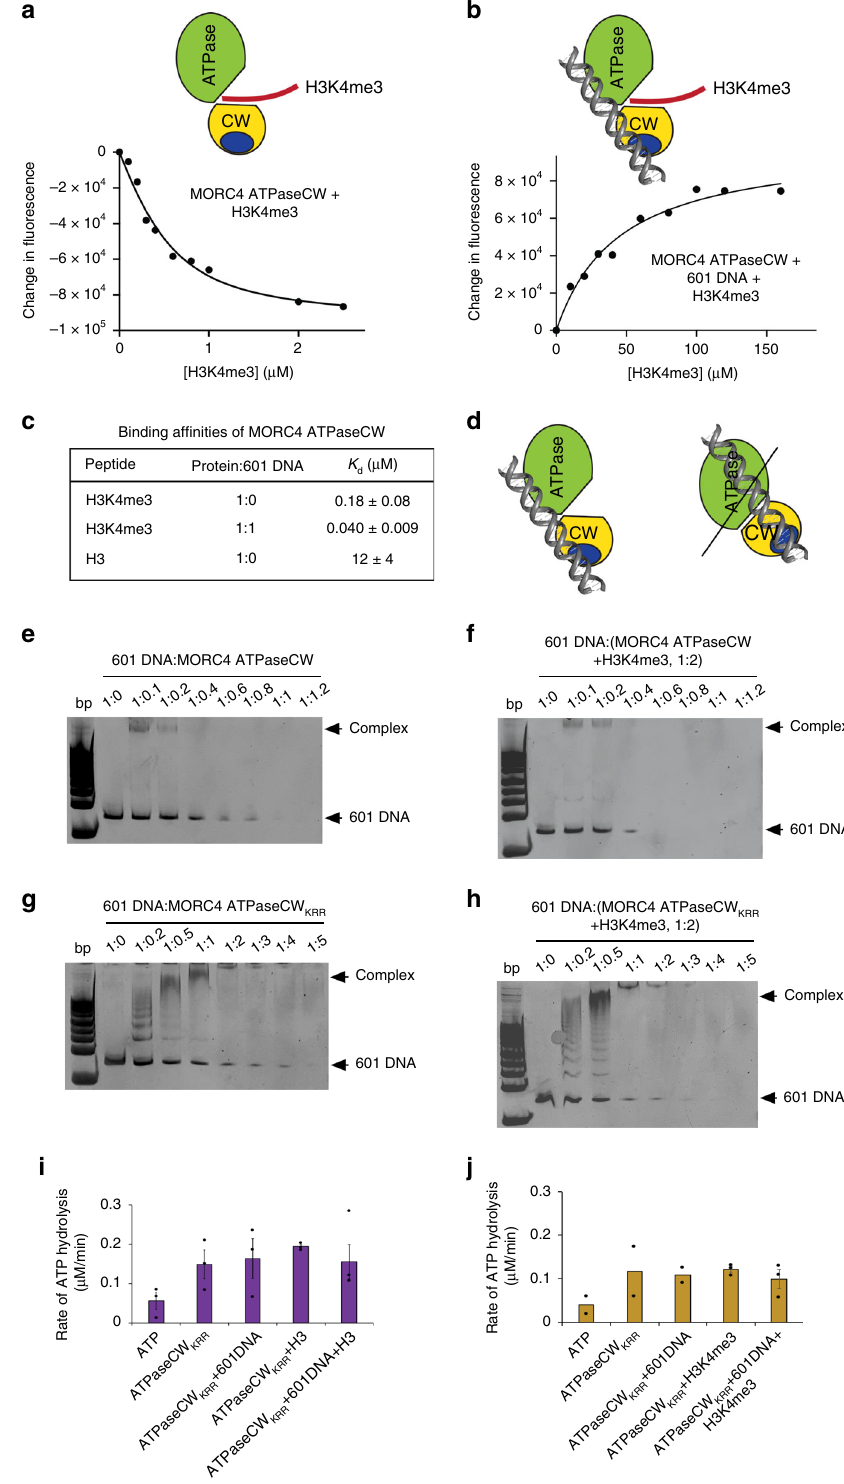
current model for the MORC4 activation, in which DNA binding by the ATPaseCW cassette (both ATPase and CW domains are involved in this interaction) promotes the catalytic activity and binding of CW to H3K4me3 (Fig. 4d). This model was further corroborated by EMSA experiments (Fig. 4e – h). First, the presence of H3K4me3 peptide slightly increased binding of either wild-type ATPaseCW or mutated